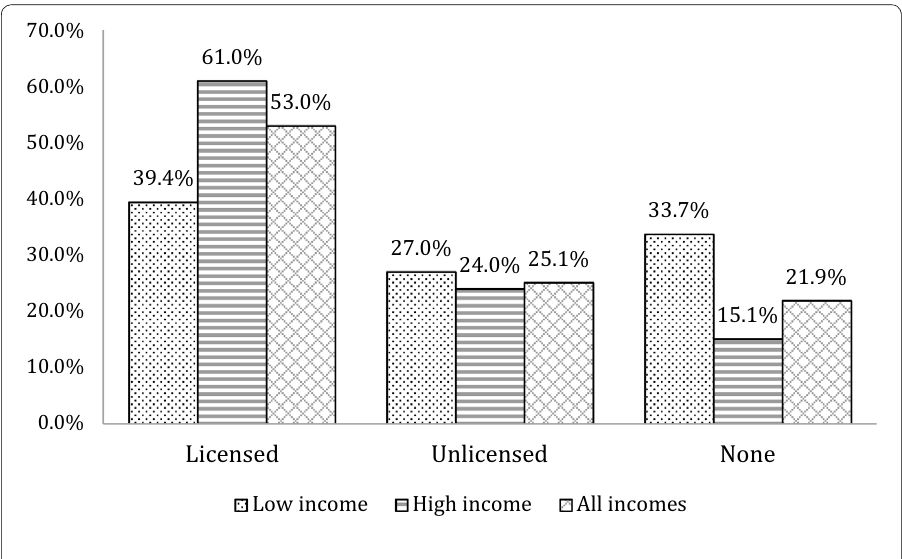
Fig. 4 Ontario children in working families by sector of care and